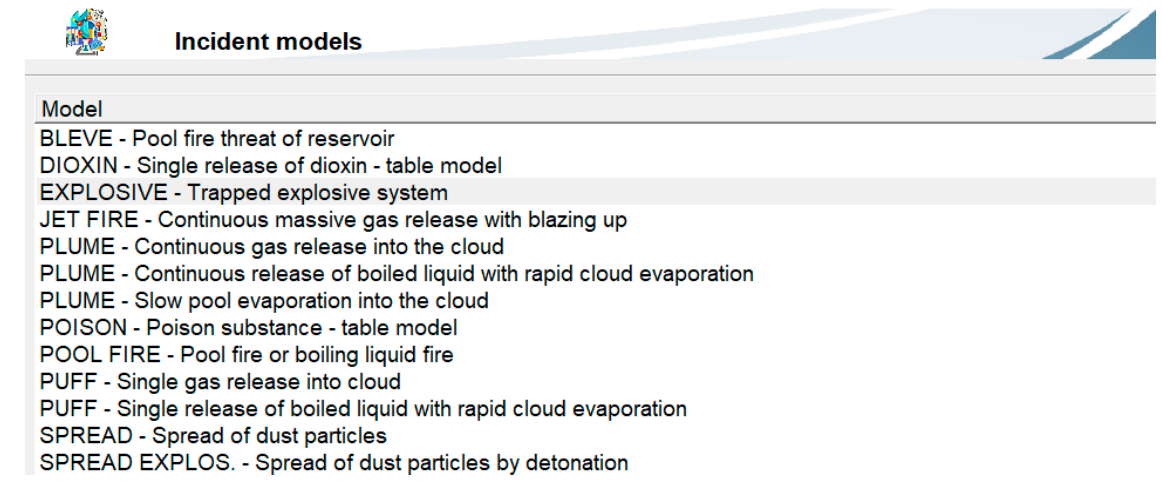
Figure 6. Overview of incident models.